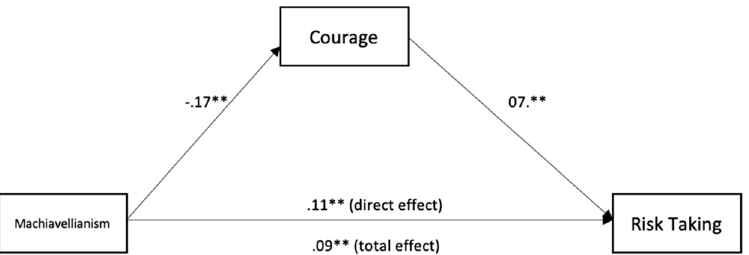
Figure 2. Mediation analysis for the relationship between Machiavellianism, honesty, and risk-taking. ** p < 0.01.